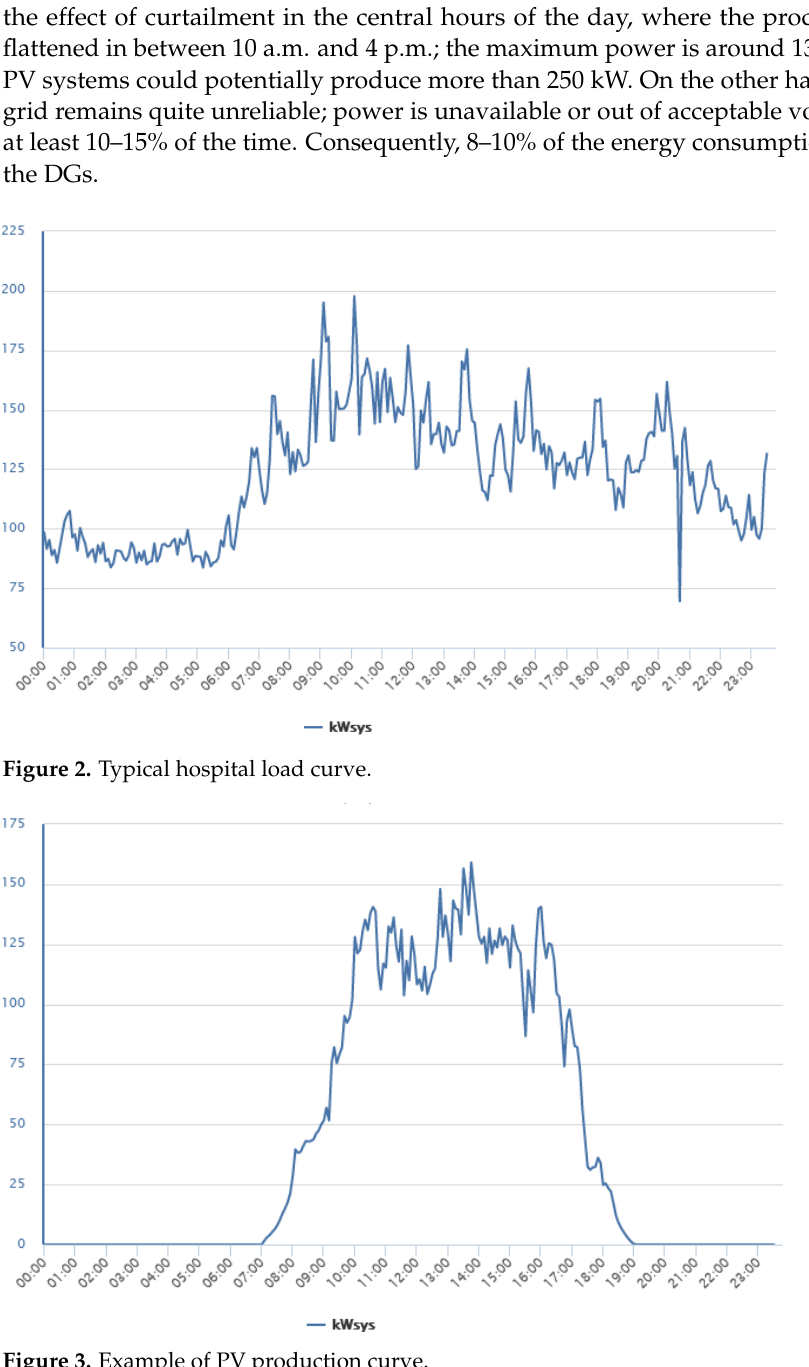
Figure 3. Example of PV production